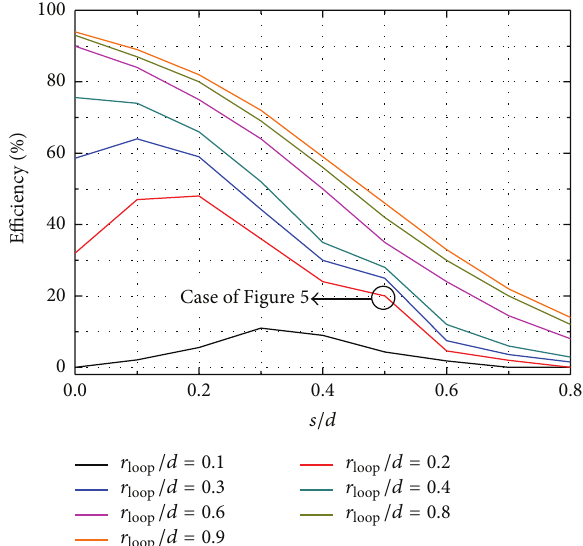
Figure 7: EM-simulated efficiencies as a function of 𝑠/𝑑 for different /𝑑 when the 𝑄 -factor of loops 1 and 2 is 473 and an ideal 𝑟 loop isotropic slab with 𝜇 𝑟 = −1 − 𝑗0.23 is